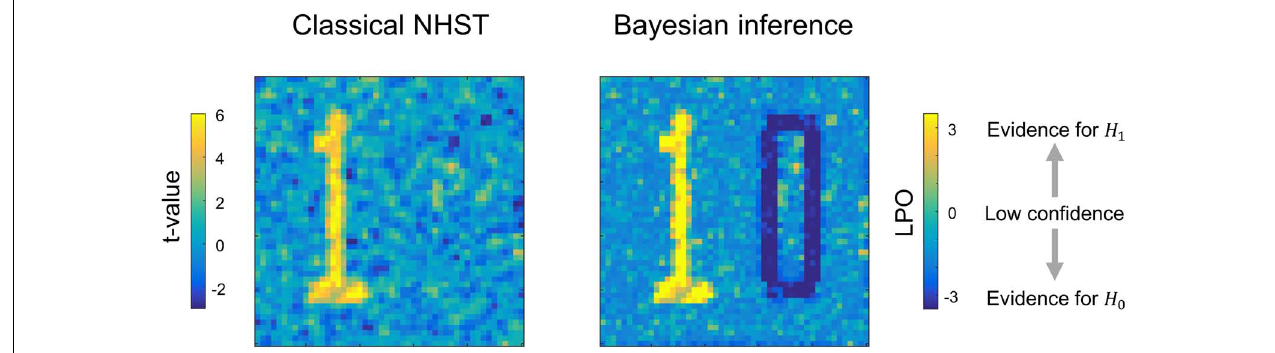
FIGURE 1 | Possible results for the same data, obtained using classical NHST and Bayesian parameter inference. Classical NHST detects only areas with a statistically significant difference (‘number one’). Bayesian parameter inference based on the logarithm of posterior probability odds ( LPO ) provides us with additional information that is not available in classical NHST: (1) it provides relative evidence for the null ( H 0 ) and alternative ( H 1 ) hypotheses, (2) it detects areas with a trivial effect size (‘number zero’), (3) it indicates ‘low confidence’ areas surrounding the ‘number one’ and ‘number zero.’ To make this conceptual illustration, we generated 100 images consisted of 50 × 50 voxels smoothed by 2 voxel full width at half maximum (FWHM) Gaussian kernel. Data were drawn from normal distributions with different mean, m, and standard deviation, SD. For the ‘number one,’ m = 0.1, SD = 0.37. For the ‘number zero,’ m = 0, SD = 0.6. For the ‘low confidence’ area, m = 0.01, SD = 0.37. LPOs were calculated using an effect size threshold of 0.02. The code to recreate the illustration is available online